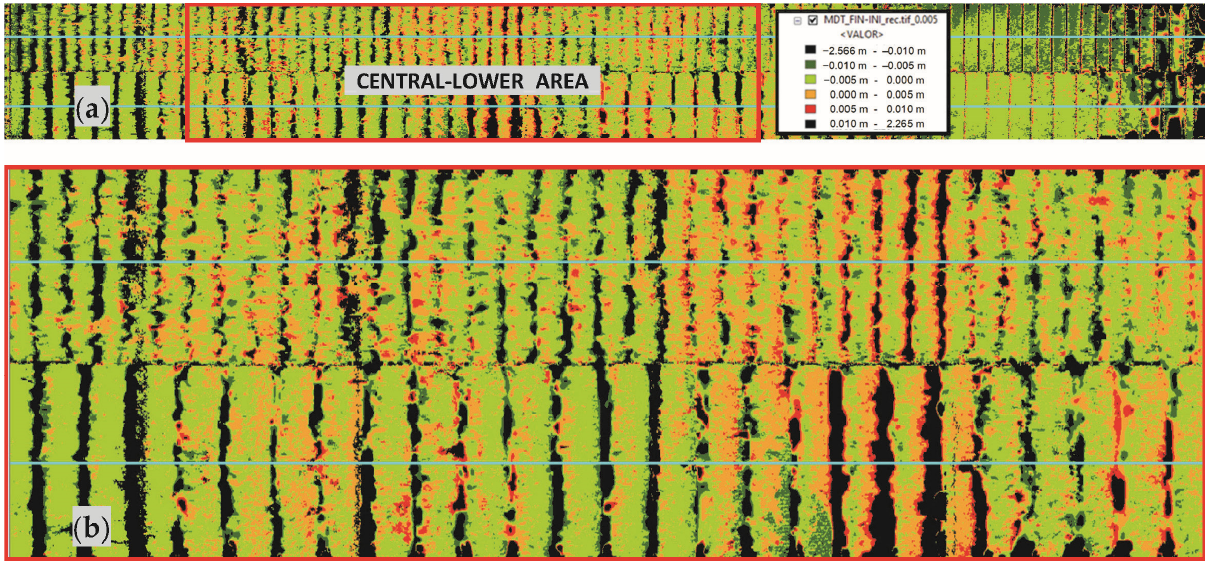
Figure 17. ( a ) Sketch of the situation of the central-lower rows in the testing chute ( b ) Detail of the upstream area of the channel (rows #6 to #43 of the small WSB, in the upper part of the photograph, and rows #4 to #29 of the medium WSB, at the bottom of the figure).